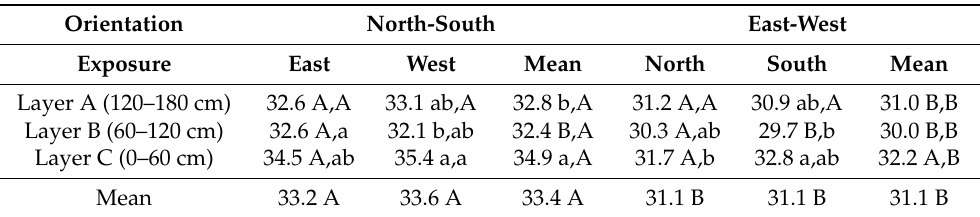
Table 12. Mean shelling percentage (SP, %). The first letters denote significant differences between layers for a given exposure; the second letters denote significant differences between exposures for a given layer (SNK test). Lower case letters denote statistical differences with p = 0.05. Capital letters denote statistical differences with p = 0.01.